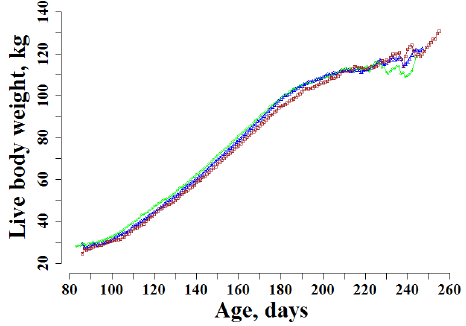
Figure 1. Relationship between live body weight, x axis, and age of pig in days, y axis. The brown, green and blue lines represent Duroc, Landrace and Yorkshire breeds, respectively. Table 1. Logistic function for the three breeds studied. Breed Logistic function Duroc y = 138 1 + 34 . 32 e − 0 . 0233 x Landrace Figure 2. (a) Daily average number of visits (DAvNV) to FIRE; (b) average feed intake weight per visit (AvFIWPV), kg; and (c) av- erage occupation time per visit (AvOTPV), min, over 24h ( x